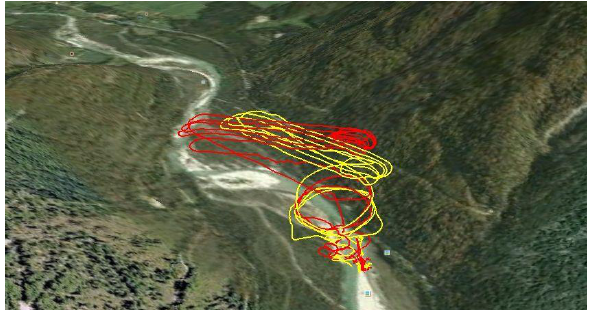
Figure 14 PAMS flight paths